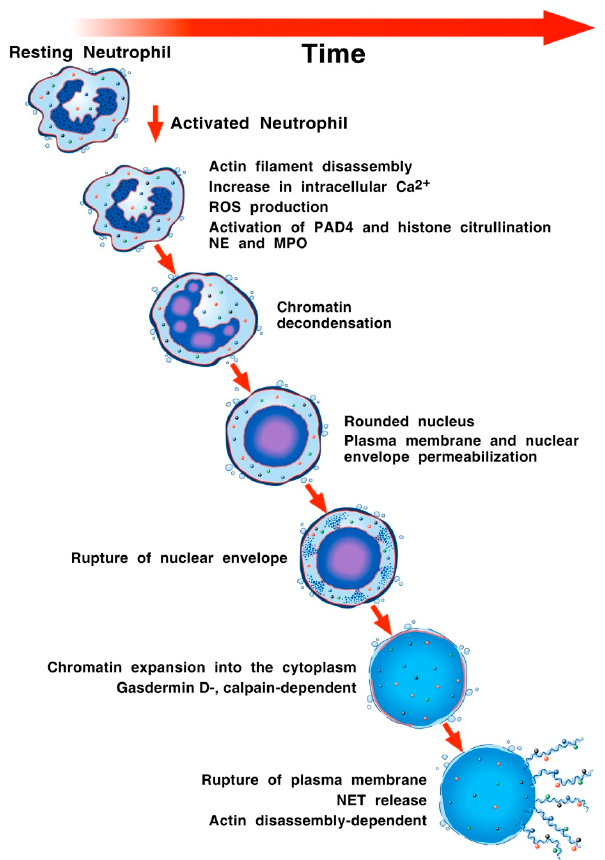
Figure 1. Schematic representation of biochemical and cellular events driving lytic NET formation. A multitude of extracellular pathogens, including viruses and bacteria, can induce lytic NET formation, also called NETosis [18,75]. Activation of neutrophils induces actin filament disassembly, an increase in intracellular Ca 2+ and ROS production. Neutrophil elastase (NE) [68] and myeloperoxidase (MPO) [76] contribute to nuclear membrane permeabilization and unfolding of chromatin. Peptidyl arginine deiminase 4 (PAD4), mainly expressed in the nucleus of granulocytes, mediates citrullination of the nucleosome histones leading to chromatin decondensation [77]. These events favor nuclear rounding and nuclear envelope permeabilization. The following event is the chromatin swelling into the cytoplasm and the activation of gasdermin D [78]. A final step is the plasma membrane rupture and NET release [79]. The release of extracellular traps can also occur without cell death [18,72–74,80,81]. NETs released during vital NET formation are composed of nuclear and mitochondrial DNA (mtDNA) and can be formed independently of NADH oxidase or ROS. In contrast to suicidal NETosis, vital NET formation is a rapid process occurring within 60 min and without affecting neutrophil viability [66,72,73,82]. Figure 2 schematically illustrates the fundamental mechanisms of suicidal neutrophils cytolysis (also termed NETosis) and of vital NET formation. NET clearance is an endocytic process promoted by macrophages and DCs [83,84] . These cells are able to degrade NETs by interplaying with extracellular and secreted DNases followed by intracellular uptake [85].